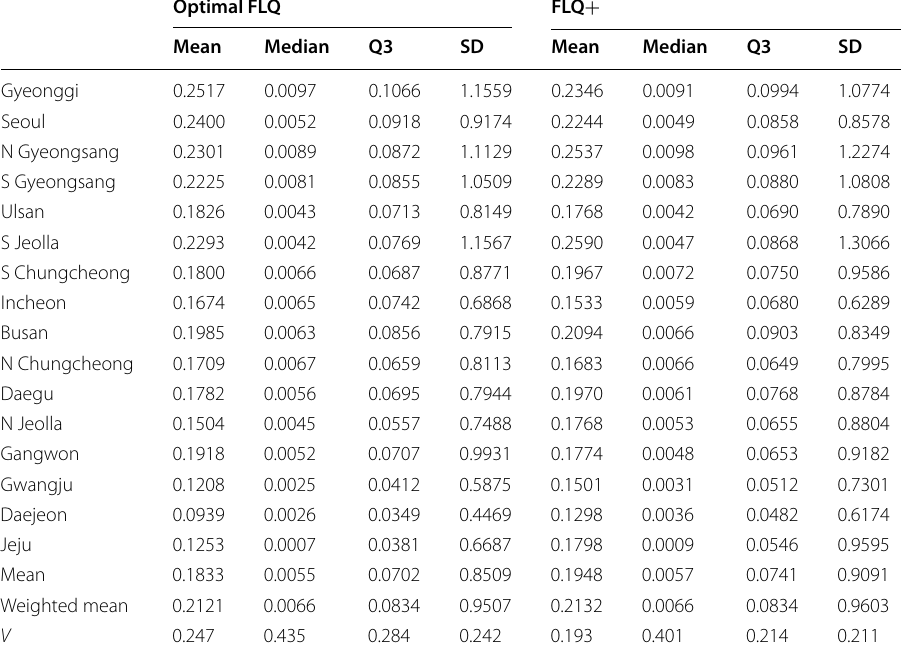
Table 5 Descriptive indices ( FLQ methods +